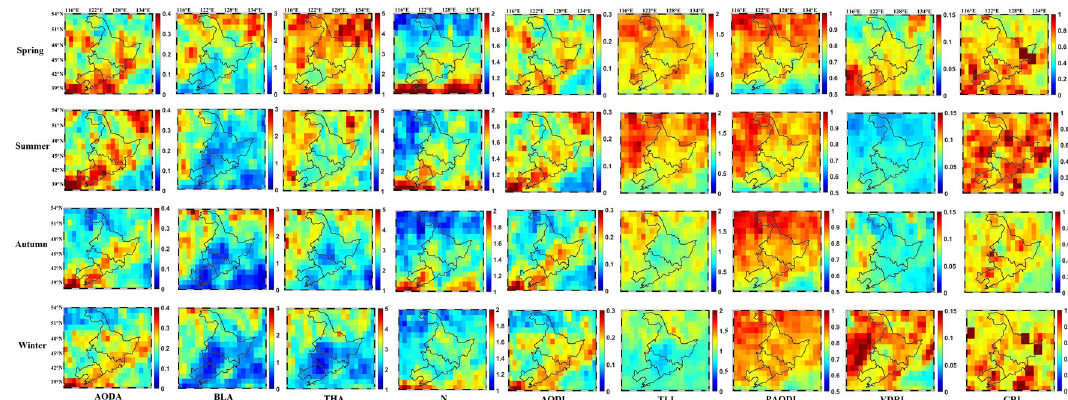
Figure 8. Seasonal spatial distributions of AODA, BAL, TAH, N, AODL, TLL, PAODL, VDRL, and CRL over NEC (HLJ, JL, and LN) in the daytime.